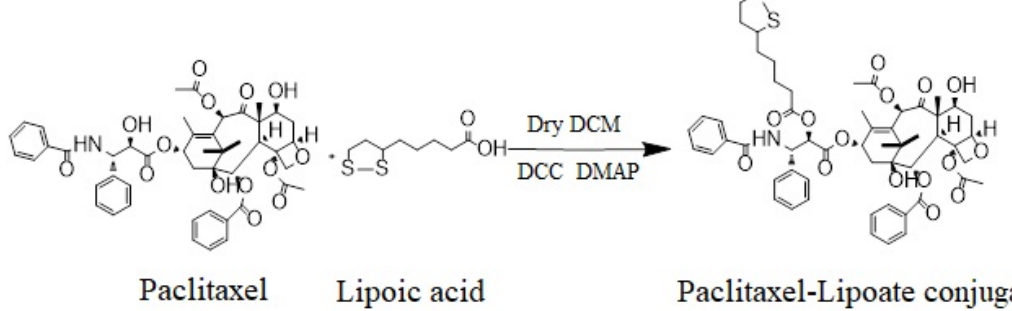
Figure 10. The synthesis pathway of IDD-1040.